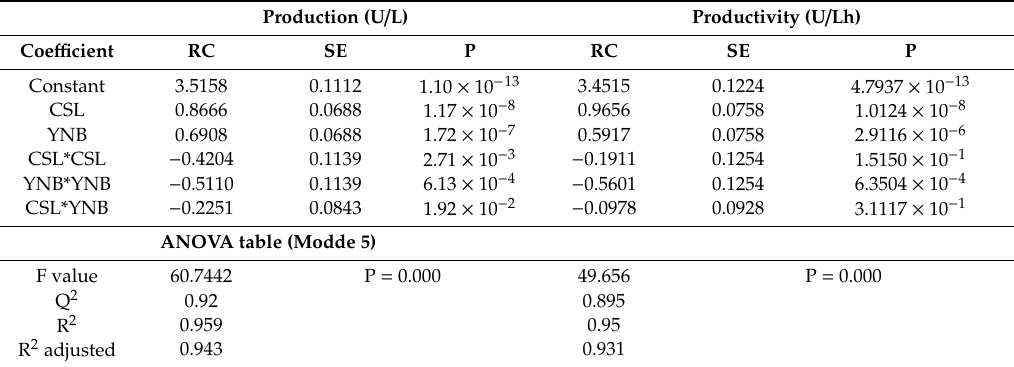
Table 2. Model coe ffi cients estimated by multiple linear regression (significance of regression coe ffi